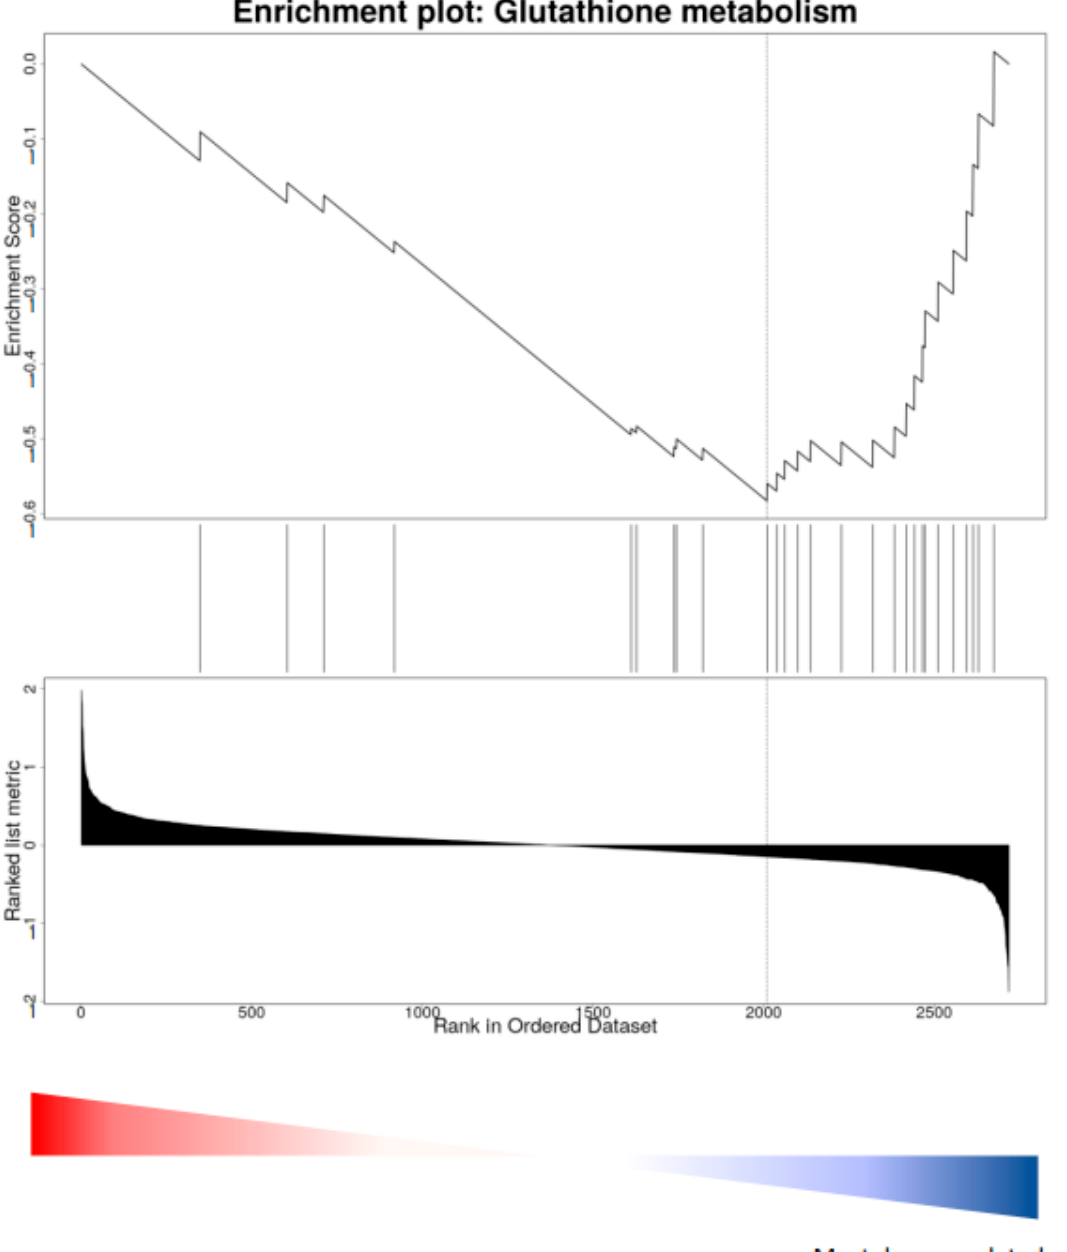
Figure 6. Example of relevant gene set enrichment analysis. Wheel-running vs. sedentary. Illustrations were generated in WEBGESTALT, all measured proteins were ranked based on fold change. The position in the ranked list of proteins belonging to rno00480 glutathione metabolism is shown as a vertical line. The plot of the enrichment score illustrates the enrichment of these proteins on the right (down-regulated) side of the list.